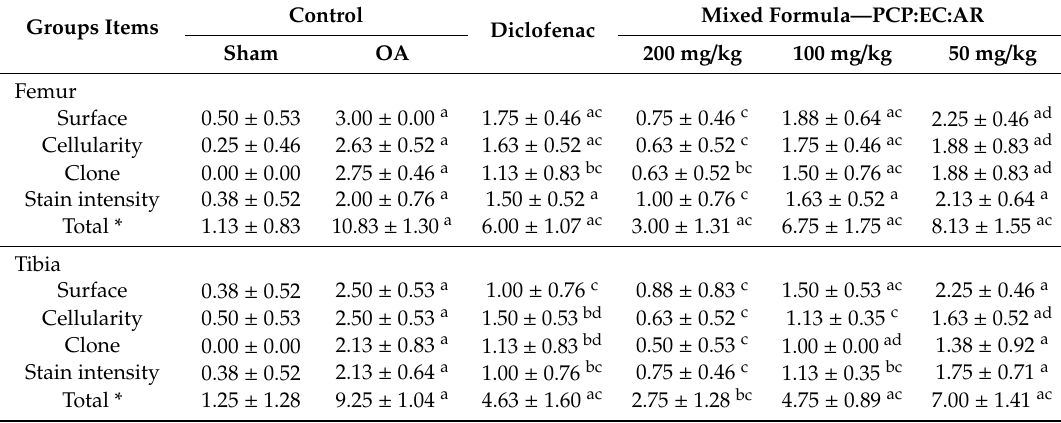
Table 5. Femur and tibia articular cartilage Mankin scores in sham-operated or OA rabbits. Groups